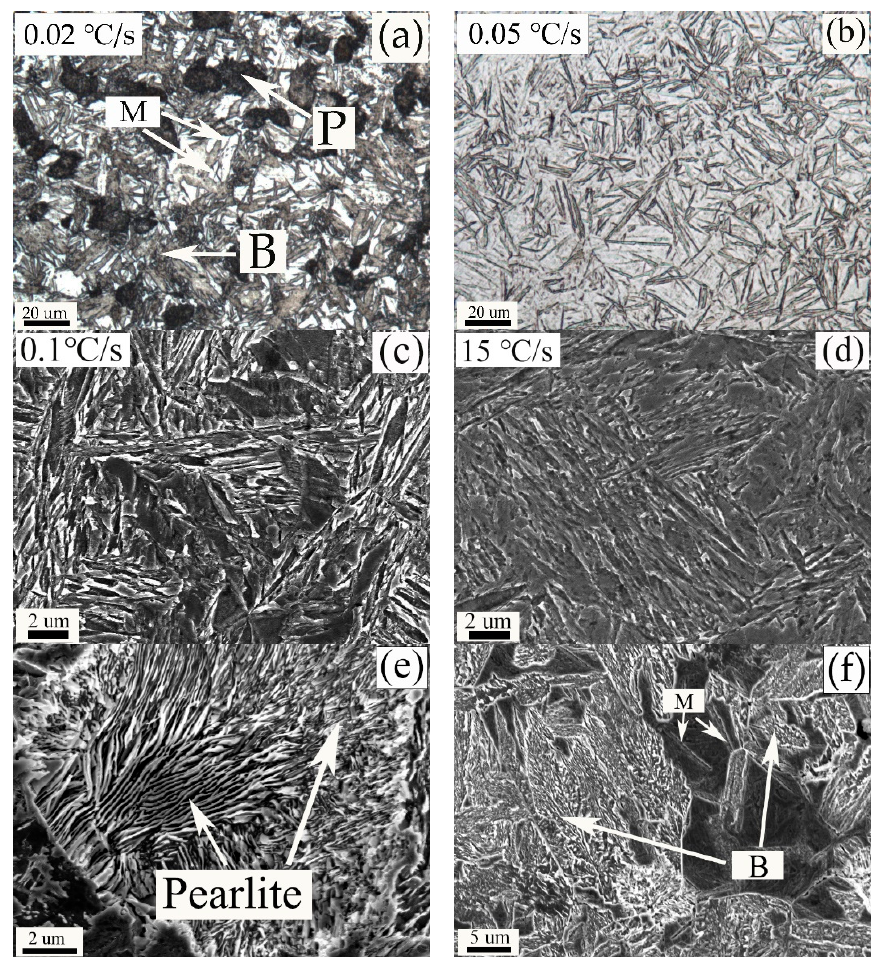
Figure 4. ( a – d ) microstructures of the cooling rate of 0.02, 0.05, 0.1 and 15 °C/s. ( e ) an enlarged view of pearlite in ( a , f ) an enlarged view of bainite and martensite in ( a ).